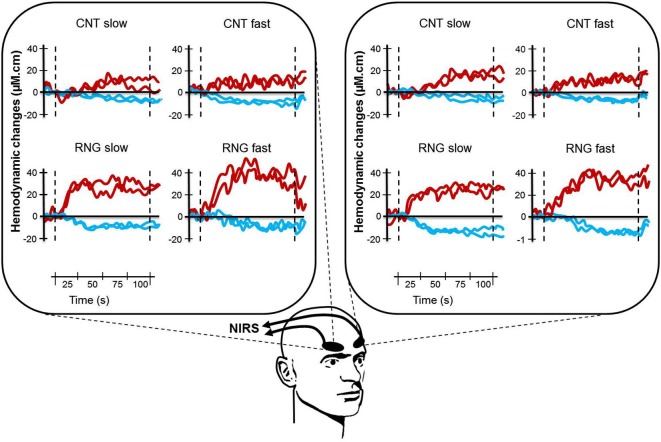
Illustration of typical cortical activation patterns for one subject as a function of task (CNT task, upper side vs. RNG task, lower side), trial and pace (slow vs. fast) for both hemispheres (right DLPFC, left panel and left DLPFC, right panel). Each curve represents one trial with [HbO2] in red and [HHb] in blue. CNT = Count task; RNG = Random Number Generation task.